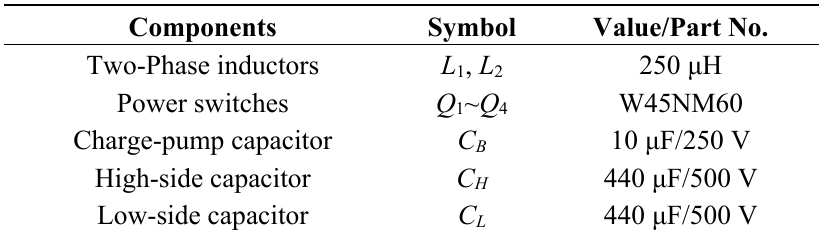
Table 1. Component parameters of the